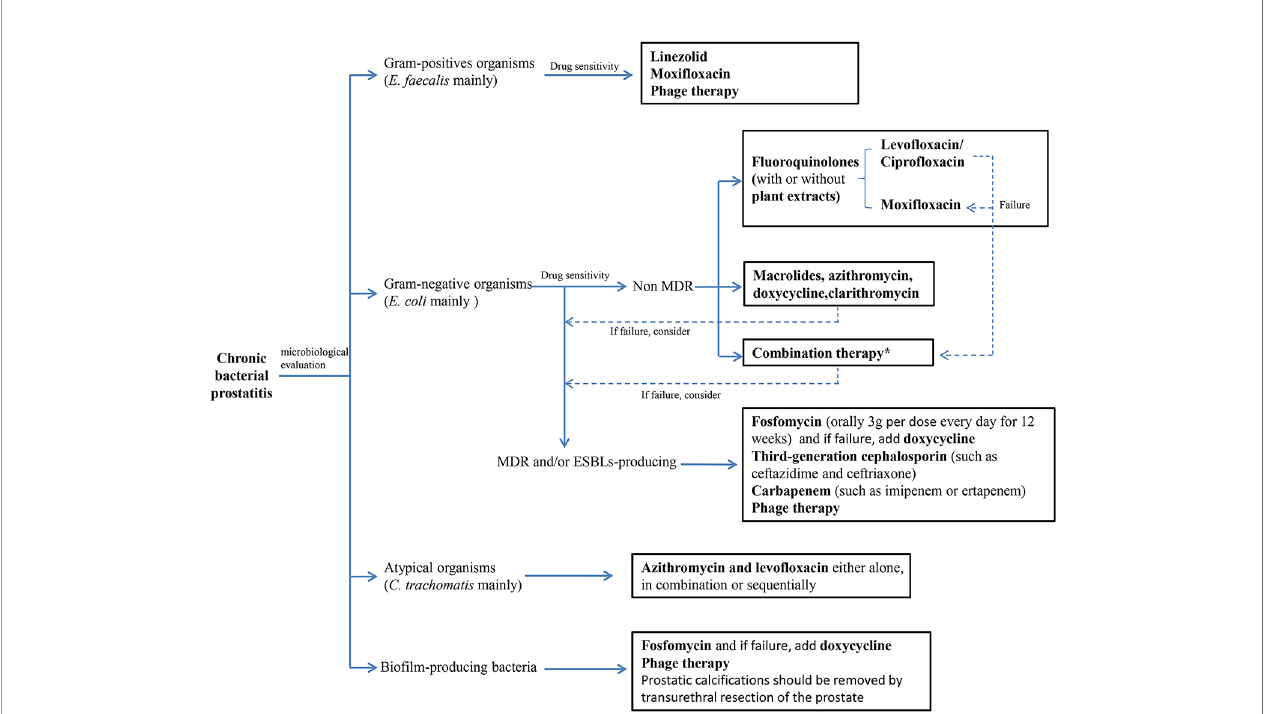
FIGURE 2 | Treatment algorithm for chromic bacterial prostatitis. (MDR, multi-drug resistance; ESBLs, extended spectrum b -lactamases). *Combination therapy: Plant extracts combinate with antibiotics, antibiotics combinate with antibiotics and other drug combinate with